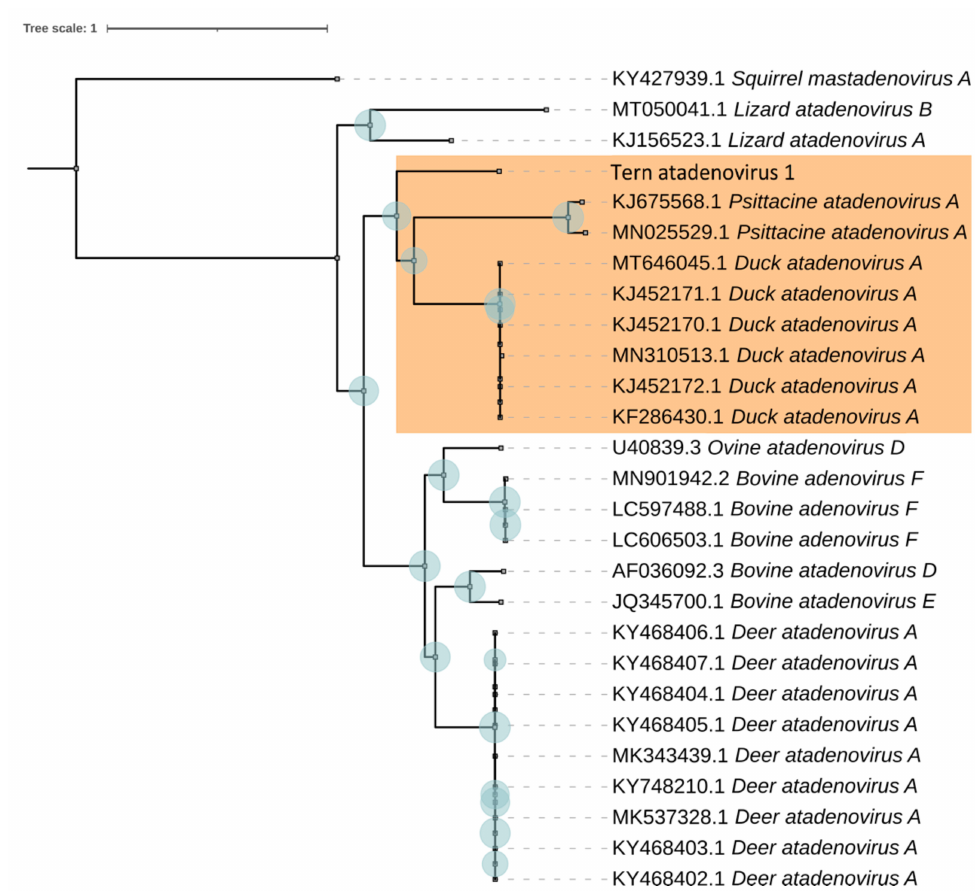
Figure 4. Maximum likelihood phylogenetic tree based on concatenated amino acid sequences of the 12 core proteins of 29 representatives of various species of the Atadenovirus genus after 1000 bootstrap replicates. Bootstrap values higher than 70 are marked next to the respective nodes (blue circles) showing a robust phylogenetic reconstruction. A clade of related species of avian viruses of the Atadenovirus genus is indicated (orange